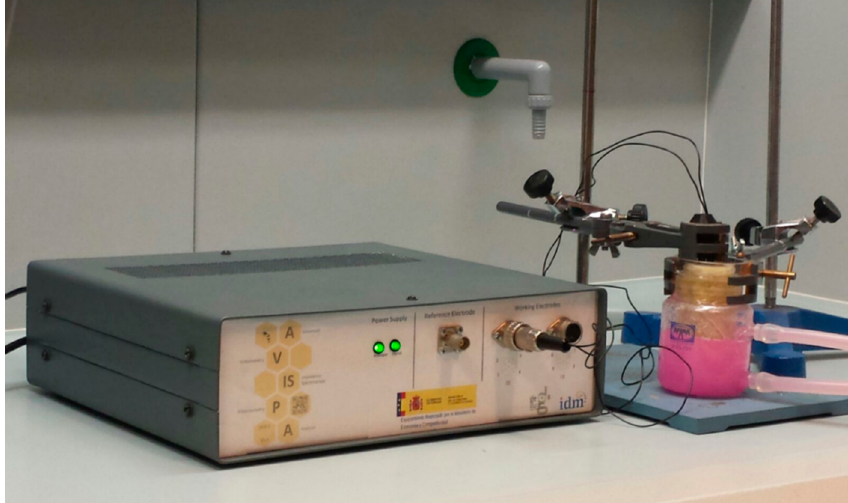
Figure 1. A view of the experimental set-up.